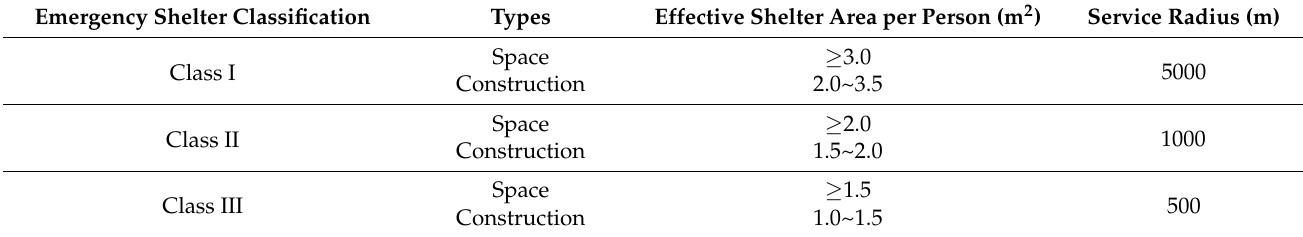
Table 1. Hierarchical control requirements for emergency shelters in Shanghai.